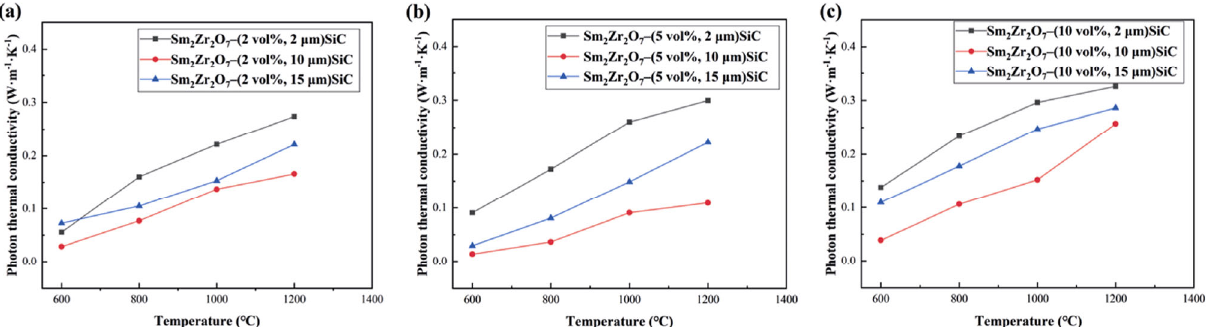
Fig. 17 Photon thermal conductivities of Sm 2 Zr 2 O 7 –SiC composites: (a) 2 vol% SiC, (b) 5 vol% SiC, and (c) 10 vol% SiC. Reproduced with permission from Ref. [101], © The Author(s)